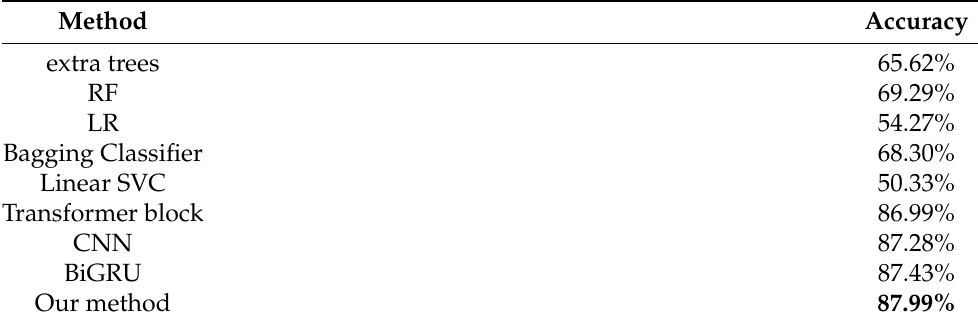
Table 4. Comparison with different methods.